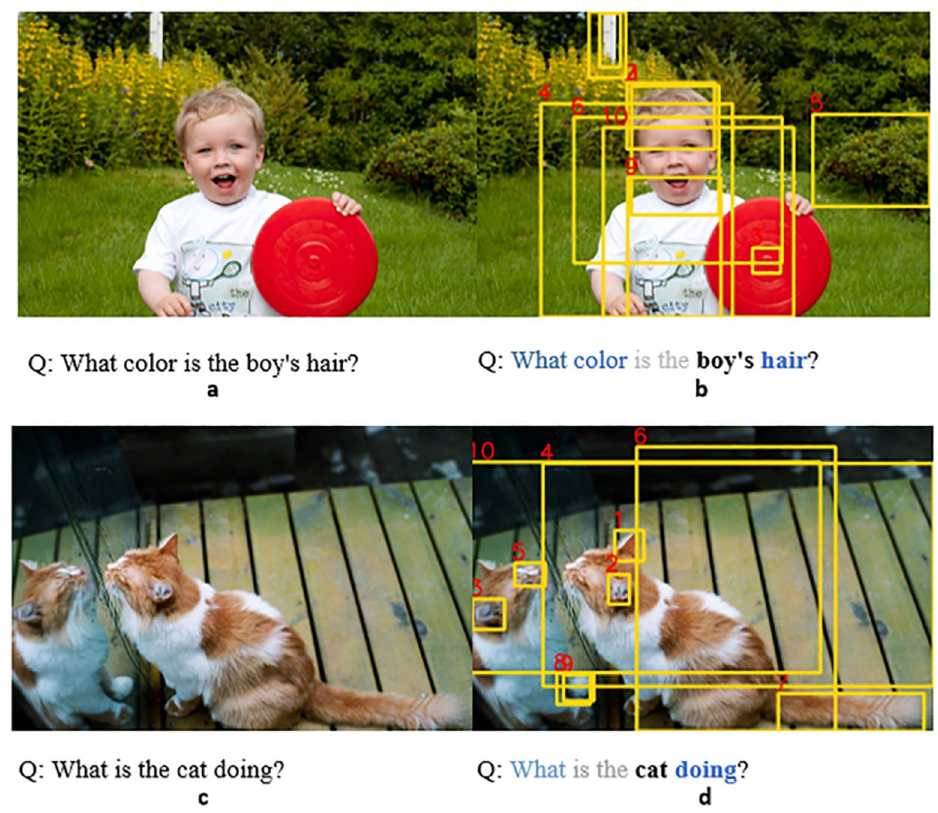
Fig 5. Attention visualization. A and B are in a group, c and D are in a group For pictures of boy and cat, reprinted from [VQA Consortium] under a CC BY license, with permission from [VQA Consortium], original copyright [2017].